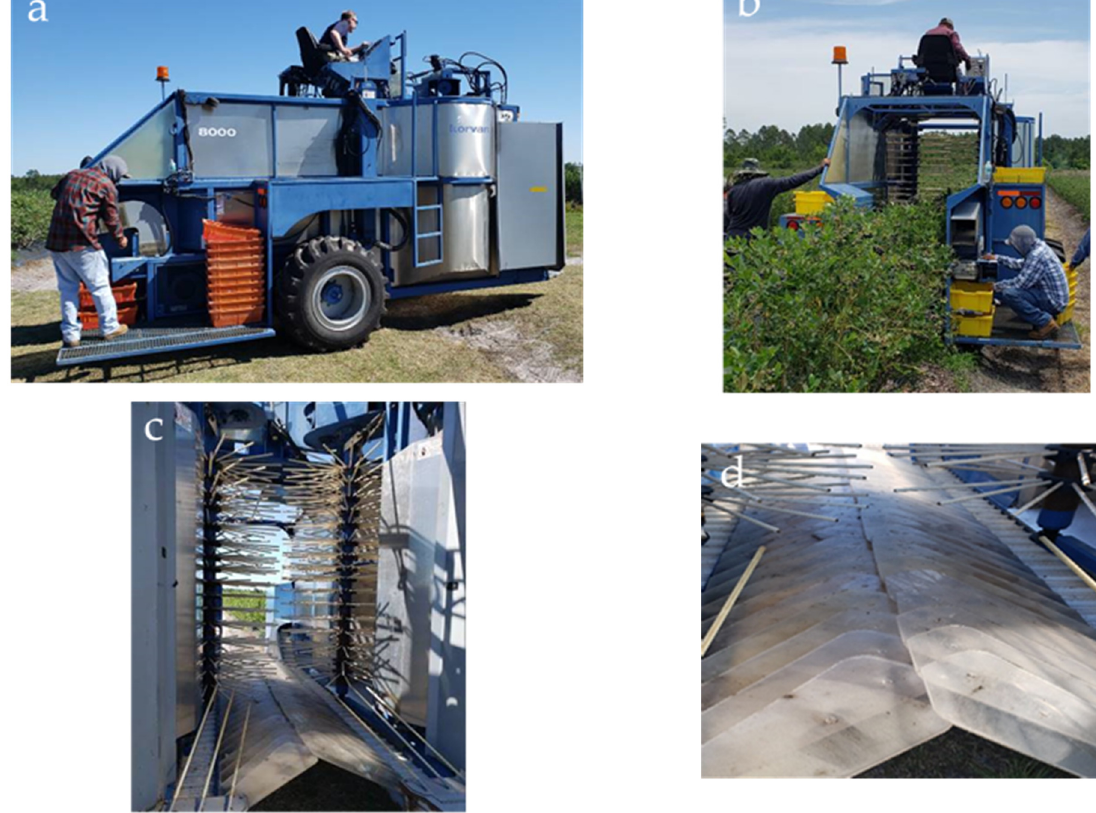
Figure 1. Conventional, over-the-row (OTR) Korvan 8000 harvester with rotary drum shakers: ( a ) Side view, ( b ) Rear view of fruit collection platforms on both sides of the harvester, ( c ) Front view of hard-catch plates, rigid conveyor belts and hard side surfaces below the drum shakers, ( d ) Closeup of hard-catch plates and rigid conveyor surfaces.